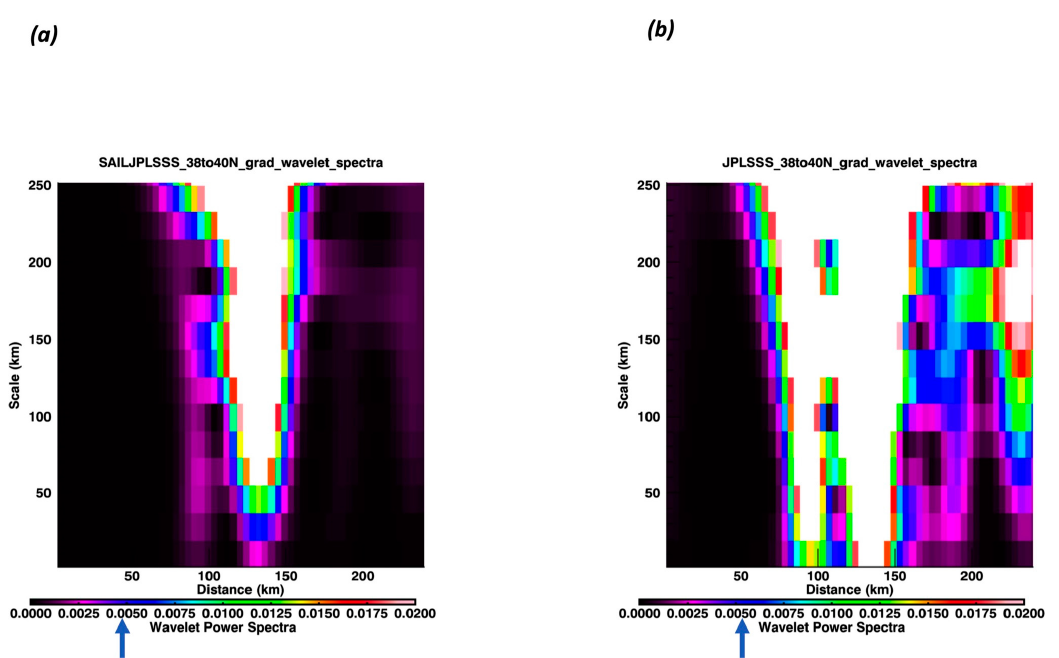
Figure 9. ( a , b ). Wavelet spectra from 38°N to 40°N for ( a ) SAILSSS and ( b ) JPLSSS. Arrows indicate the color associated with the 95% level of confidence.